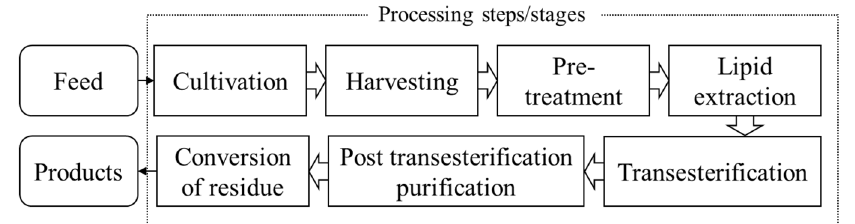
Figure 2. Major processing steps/stages.